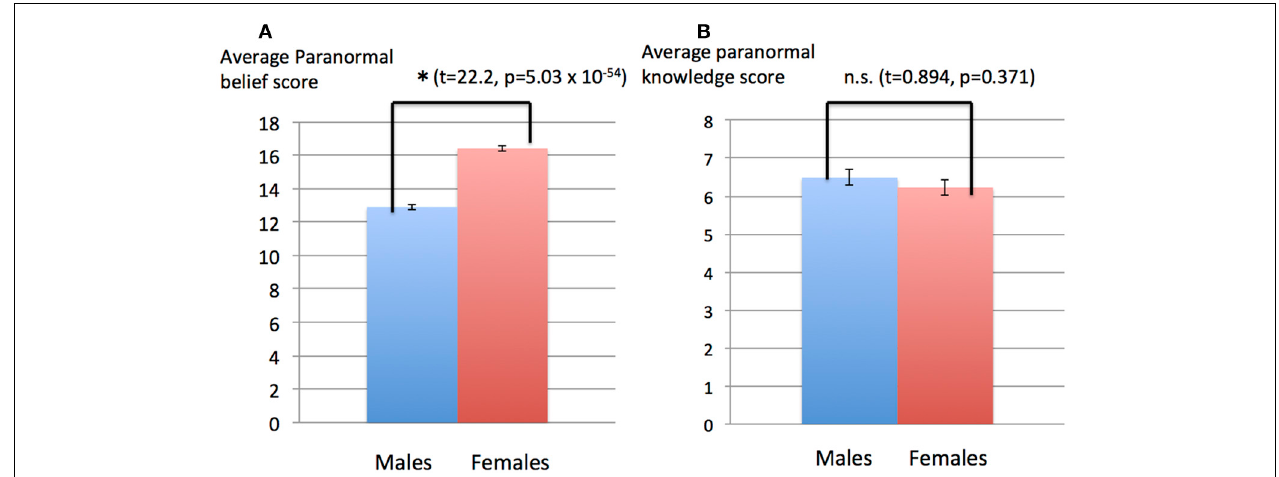
FIGURE 3 | Gender difference in paranormal belief and knowledge scores. (A) Paranormal belief scores for male and female subjects. The average paranormal belief scores for males and females were 12.9 and 16.6, respectively, with standard deviations of 5.2 and 5.4, respectively. Vertical bars represent standard errors of the mean. The difference of paranormal belief scores between the male and female subjects was significant